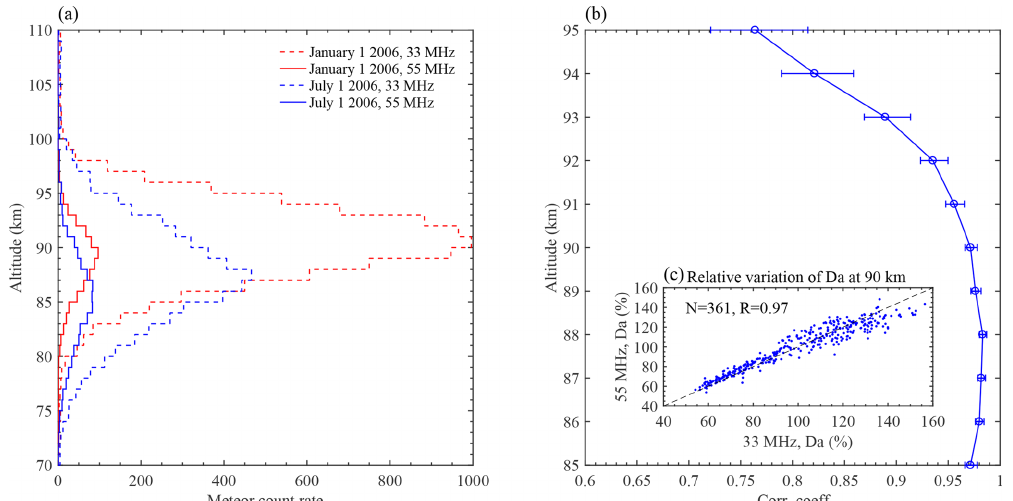
Figure 2. (a) The height distributions of meteor detections in 1km bins on 1 January and 1 July 2006 from the 33 and 55MHz meteor radars at Davis Station. (b) Height variation in the correlation coefficient between the D a observed simultaneously by the 33 and 55MHz meteor radars at Davis Station in 2006. The error bars indicate the lower and upper bounds of the 95% confidence interval for each coefficient. (c) Comparison of the variations in the daily mean D a (blue dots) at 90km simultaneously observed from the 33 and 55MHz meteor radars at Davis Station in 2006. The percentage variations in D a with respect to the yearly mean D a in 2006. N represents the number of days observed by these two radars in 2006, and R denotes the linear correlation